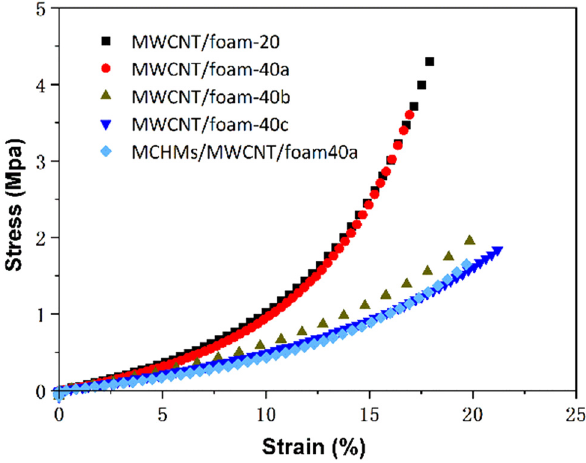
Figure 7: Stress – strain curves of MWCNT/foam - 20, MWCNT/foam - 40a, MWCNT/foam - 40b, MWCNT/foam - 40c, and MCHMs/MWCNT/foam -